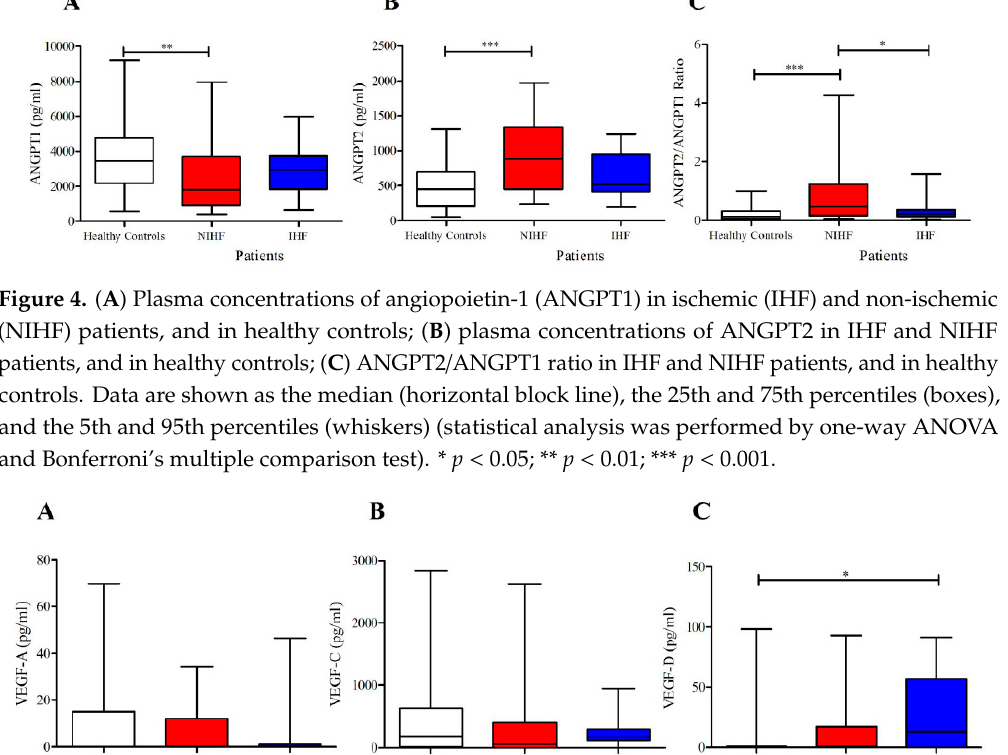
6 of 16 Figure 3. Plasma concentrations of sPLA 2 activity in HF patients and in healthy controls. Data are shown as the median (horizontal block line), the 25th and 75th percentiles (boxes), and the 5th and 95th percentiles (whiskers) (statistical analysis was performed by a Student’s t -test). ** p < 0.01; *** p < 0.001; **** p < 0.0001. 3.3. Plasma Concentrations of ANGPT1, ANGPT2 and Their Ratio in Patients With IHF and NIHF The concentrations of ANGPT1 were significantly reduced in NIHF compared to controls